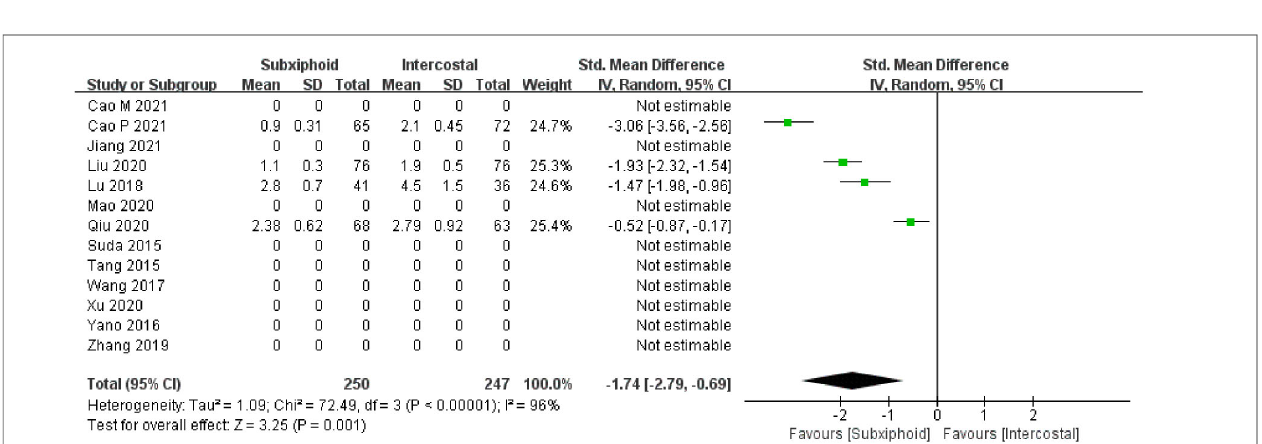
FIGURE 10 | Forest plot of the role of SMD and its 95% CI of VAS score on the third day postoperation between SVATS and IVATS groups.